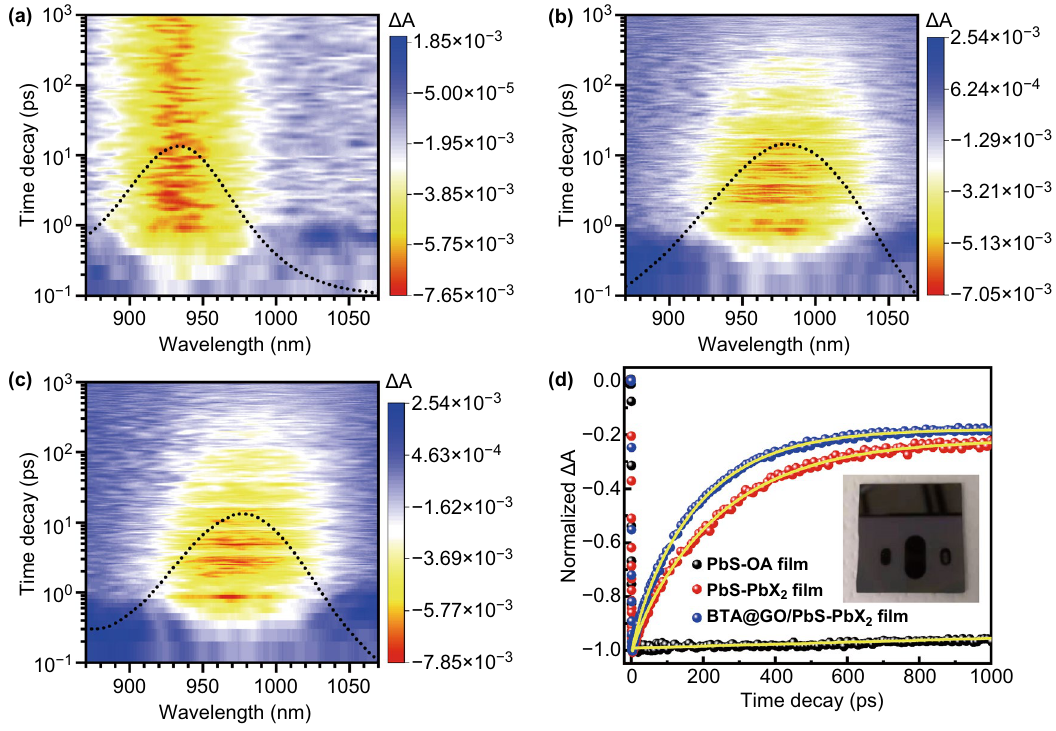
Fig. 3 Comparison of the TA decays of PbS-OA CQDs film, PbS-PbX 2 CQDs film and BTA@GO/PbS-PbX 2 hybrid CQDs film. a‑c TA and ground-state absorption spectra for PbS-OA, PbS-PbX 2 and BTA@GO/PbS-PbX 2 CQD films. The excitation wavelength is 470 nm with a pulse fluence of 20 μJ cm −2 . d Normalized absorption changes ( △ A) of those films; the films are excited by 470 nm pulse with a fluence of 6 μJ cm −2 . The inset is the photograph of BTA@GO/PbS-PbX 2 CQDs film, and the shadow of the phone used to take photo is reflected in the mirror-like surface of the CQDs